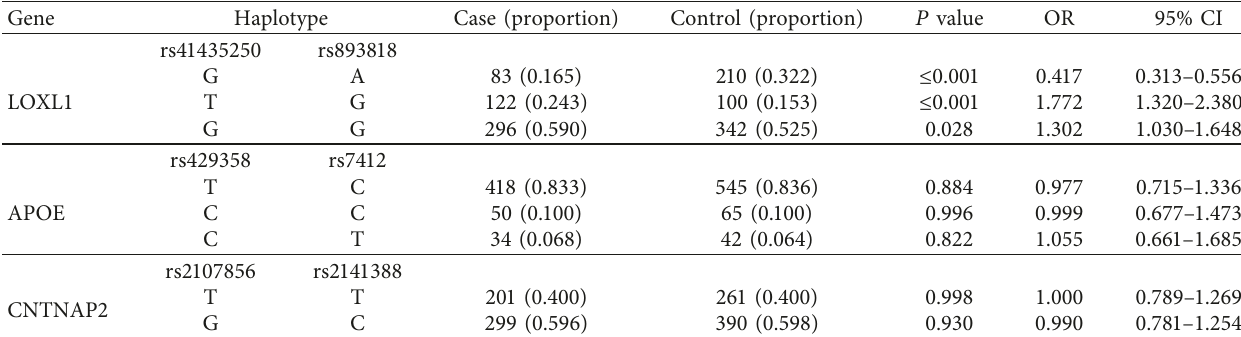
Table 6: Haplotype association analysis between these